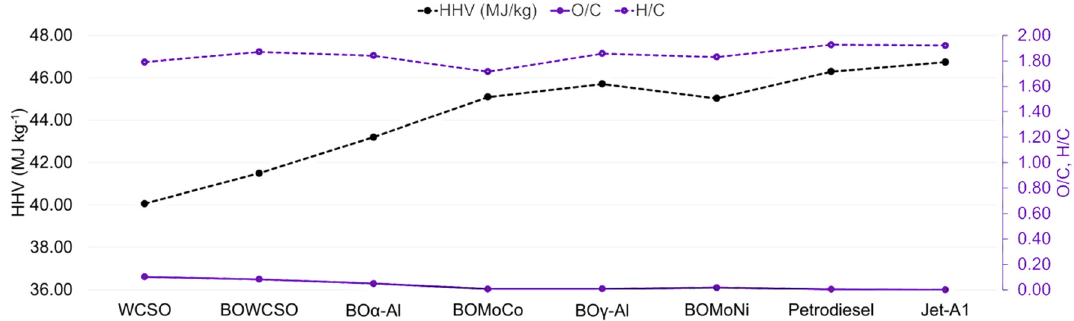
Figure 3. Heating value, O/C and H/C of the feedstock and bio-oils obtained from micropyrolysis experiments at 500 °C.